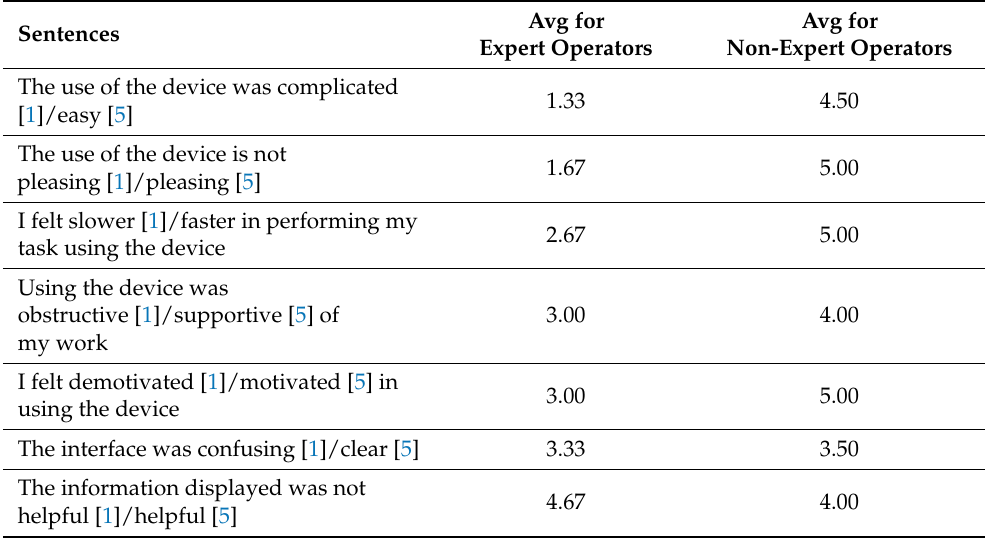
Table 9. Average responses to the questionnaire based on a five-point Likert